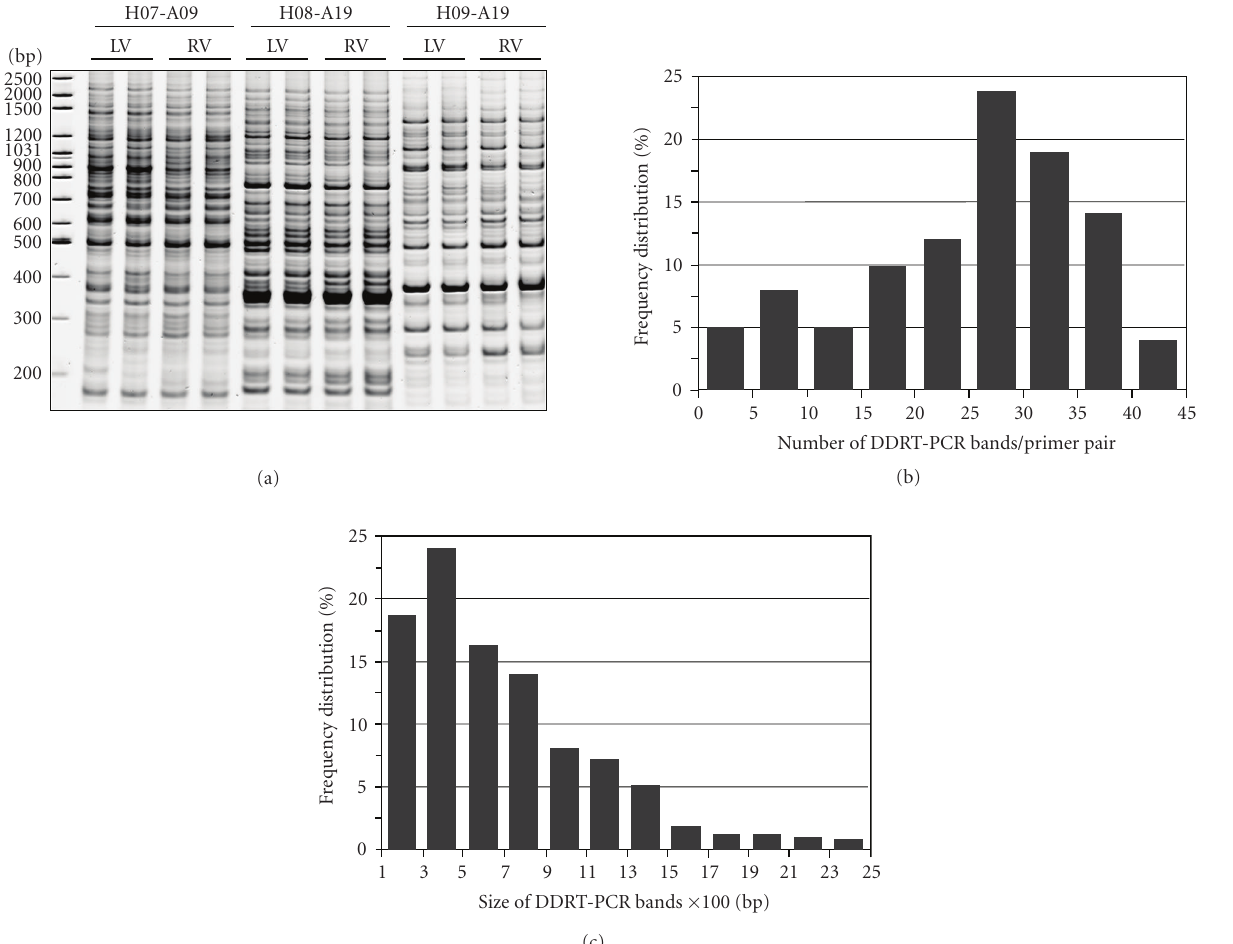
Figure 2: Di ff erential display (DDRT-PCR) analysis of gene expression in left/right ventricles (LV/RV) of newborn piglets. (a) Representative gel images of DDRT-PCR bands amplified with three distinct sets of primer combinations (H07-A09, H08-A19, and H09-A19), showing highly reproducible band patterns in each replicate. Nondenaturing 8% PAAG poststained with SYBR Green I. 200–2500 bp—DNA size standards (GeneRuler DNA ladder mix, Fermentas). (b and c) Number and size distribution frequencies of bands generated by